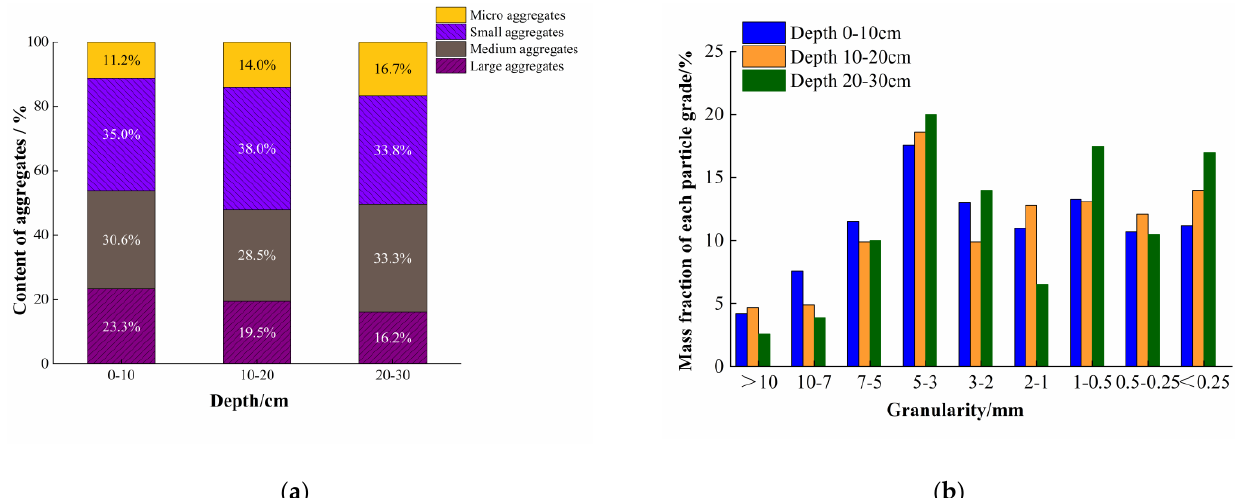
Figure 9. Distribution characteristics of aggregates. ( a ) Effect of depth on aggregates’ content; ( b ) effect of depth on the particle size of aggregates.